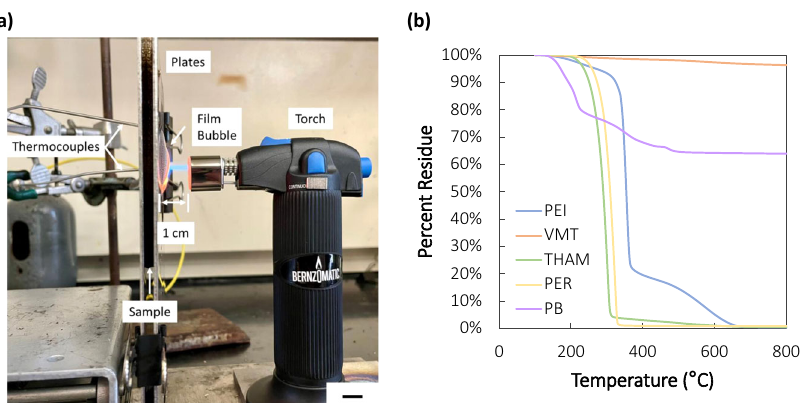
Fig. 3 Test setup and TGA of materials. a Digital image of the fl ame test setup, with components and sample labeled, and b thermogravimetric analysis of the individual materials used in making the multilayer fi lms. Scale bar for digital image is 1 cm.